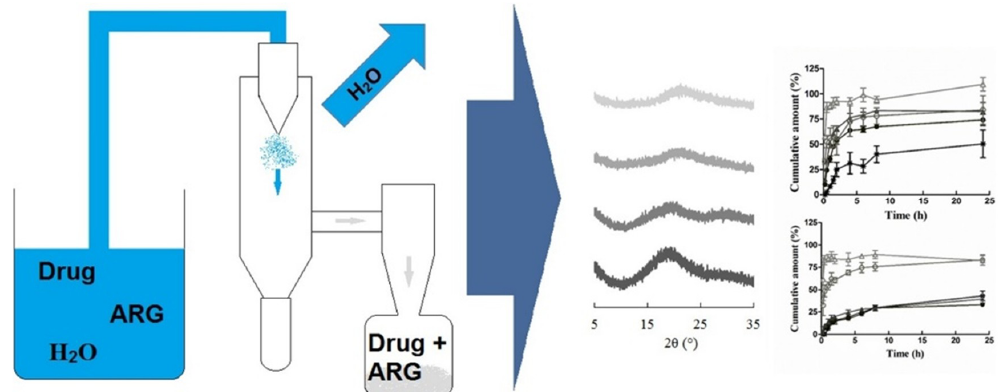
Figure 12. Preparation of co-amorphous systems by spray drying aqueous solution [55].